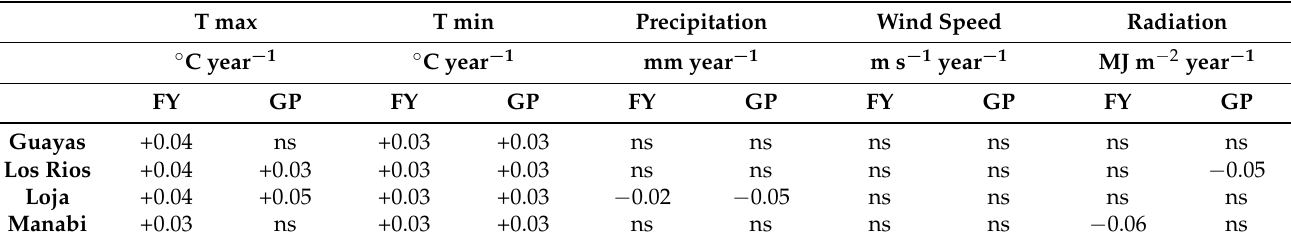
Table 2. Summary of the Sen’s Slope test. The values represent the magnitude of the variation of each parameter per year. The sign + means a increasing trend, whereas − means a decreasing trend. The ns means “not significant” and refers to the lack of significant trend for that climate parameter. FY refers to the full year approach and GP refers to the crop growing period approach.